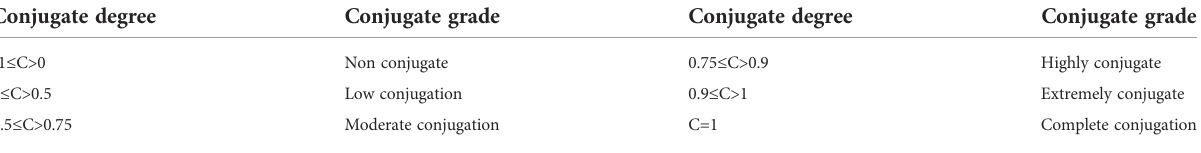
TABLE 1 Classi fi cation standard of conjugate degree of composite